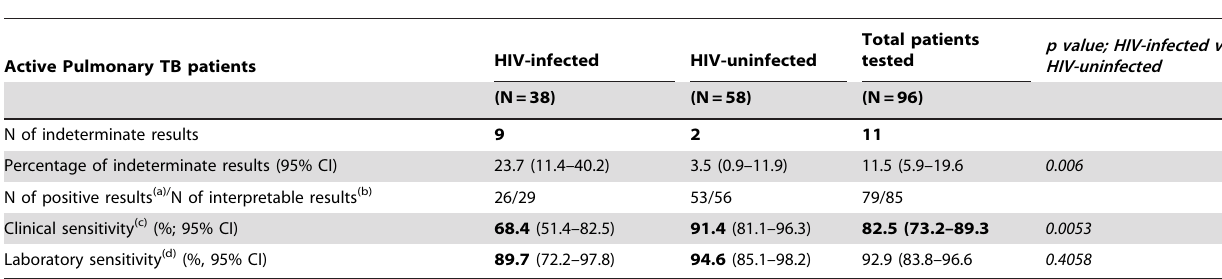
Table 2. Number and percentage (95% CI) of indeterminate results, number of positive and interpretable results and positive sensitivity rates (percentage; 95% CI) of QuantiFERON H Gold in Tube (QFT-GIT) in pulmonary TB patients stratified by HIV status and disease